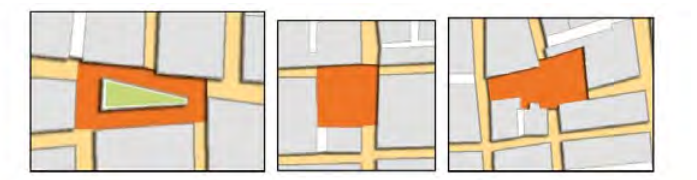
Figure 18. (Meeting Points of Rashid historic core)